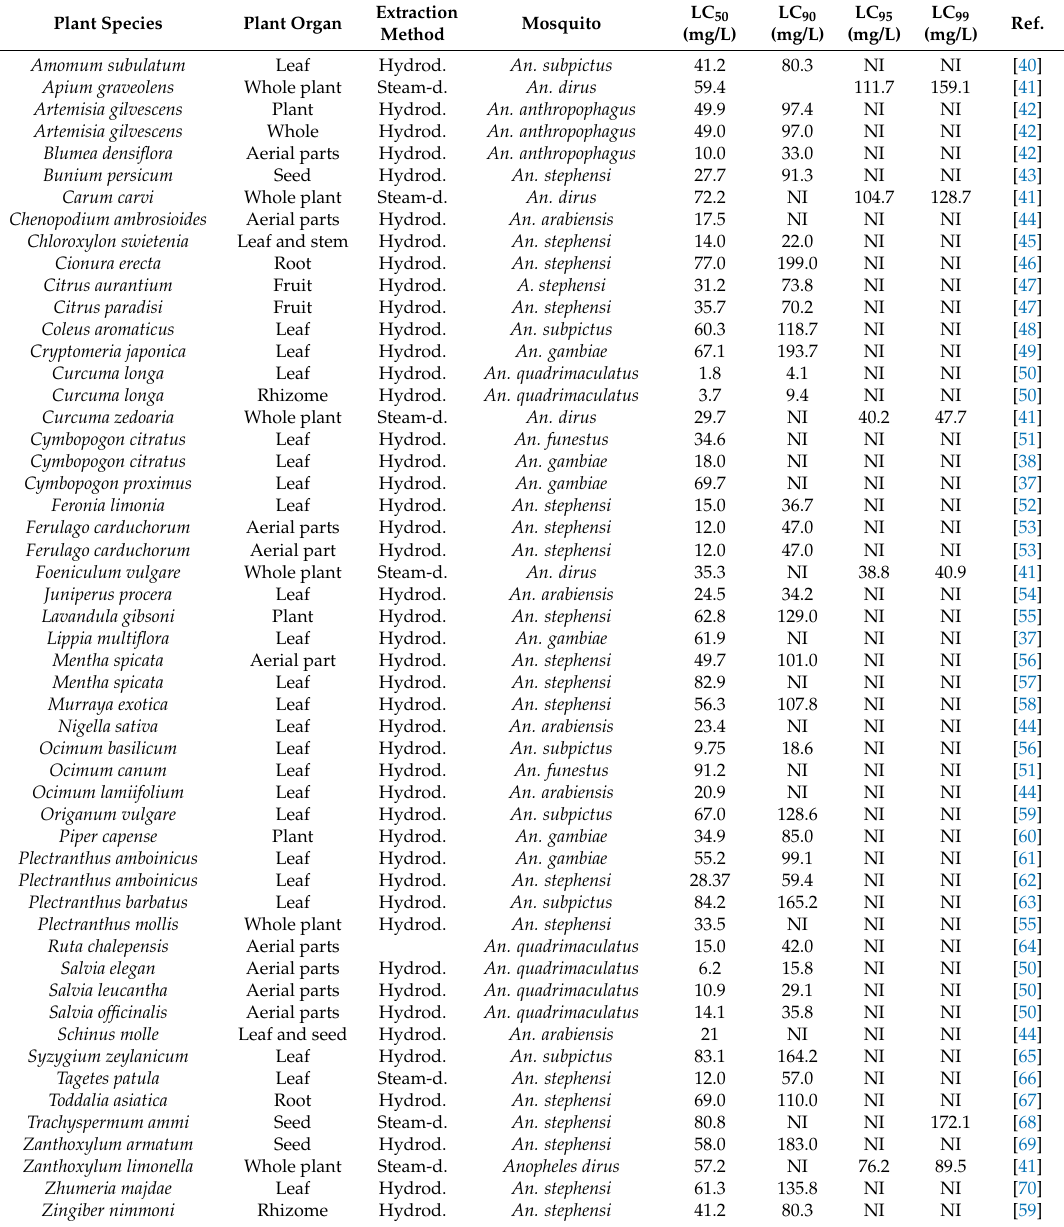
Table 2. Toxicity of essential oils against larvae of Anopheles